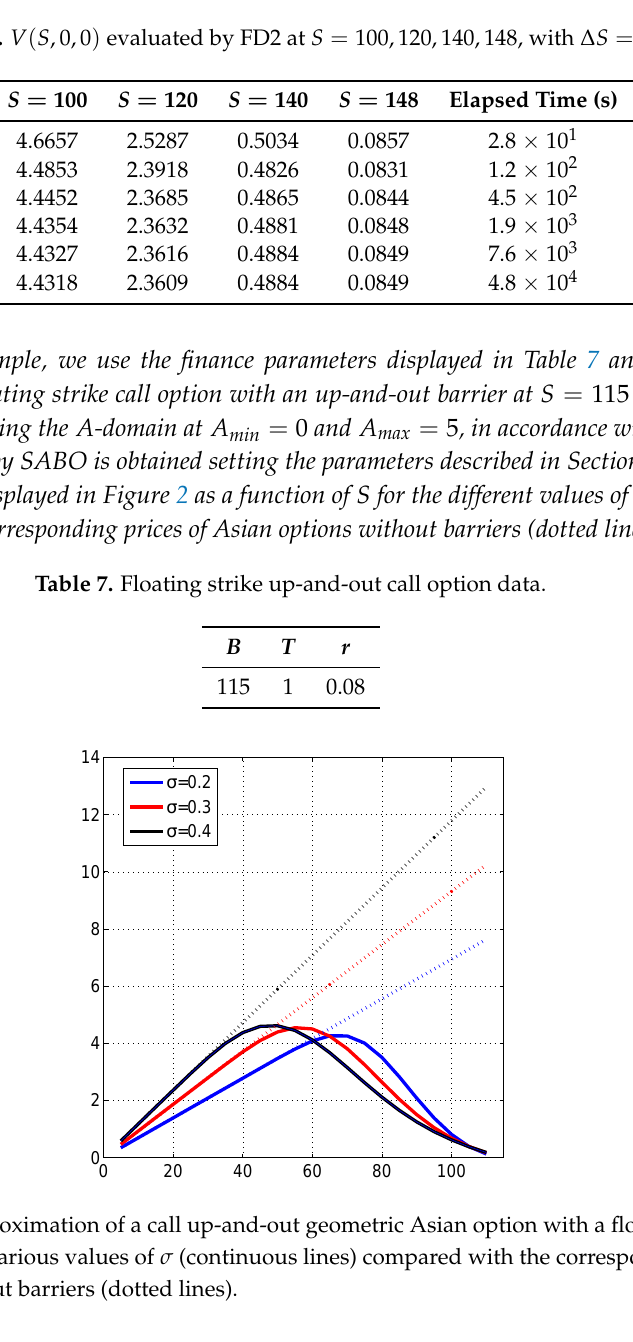
Figure 2. SABO approximation of a call up-and-out geometric Asian option with a floating strike, the data in Table 7 and various values of σ (continuous lines) compared with the corresponding prices of Asian options without barriers (dotted lines).